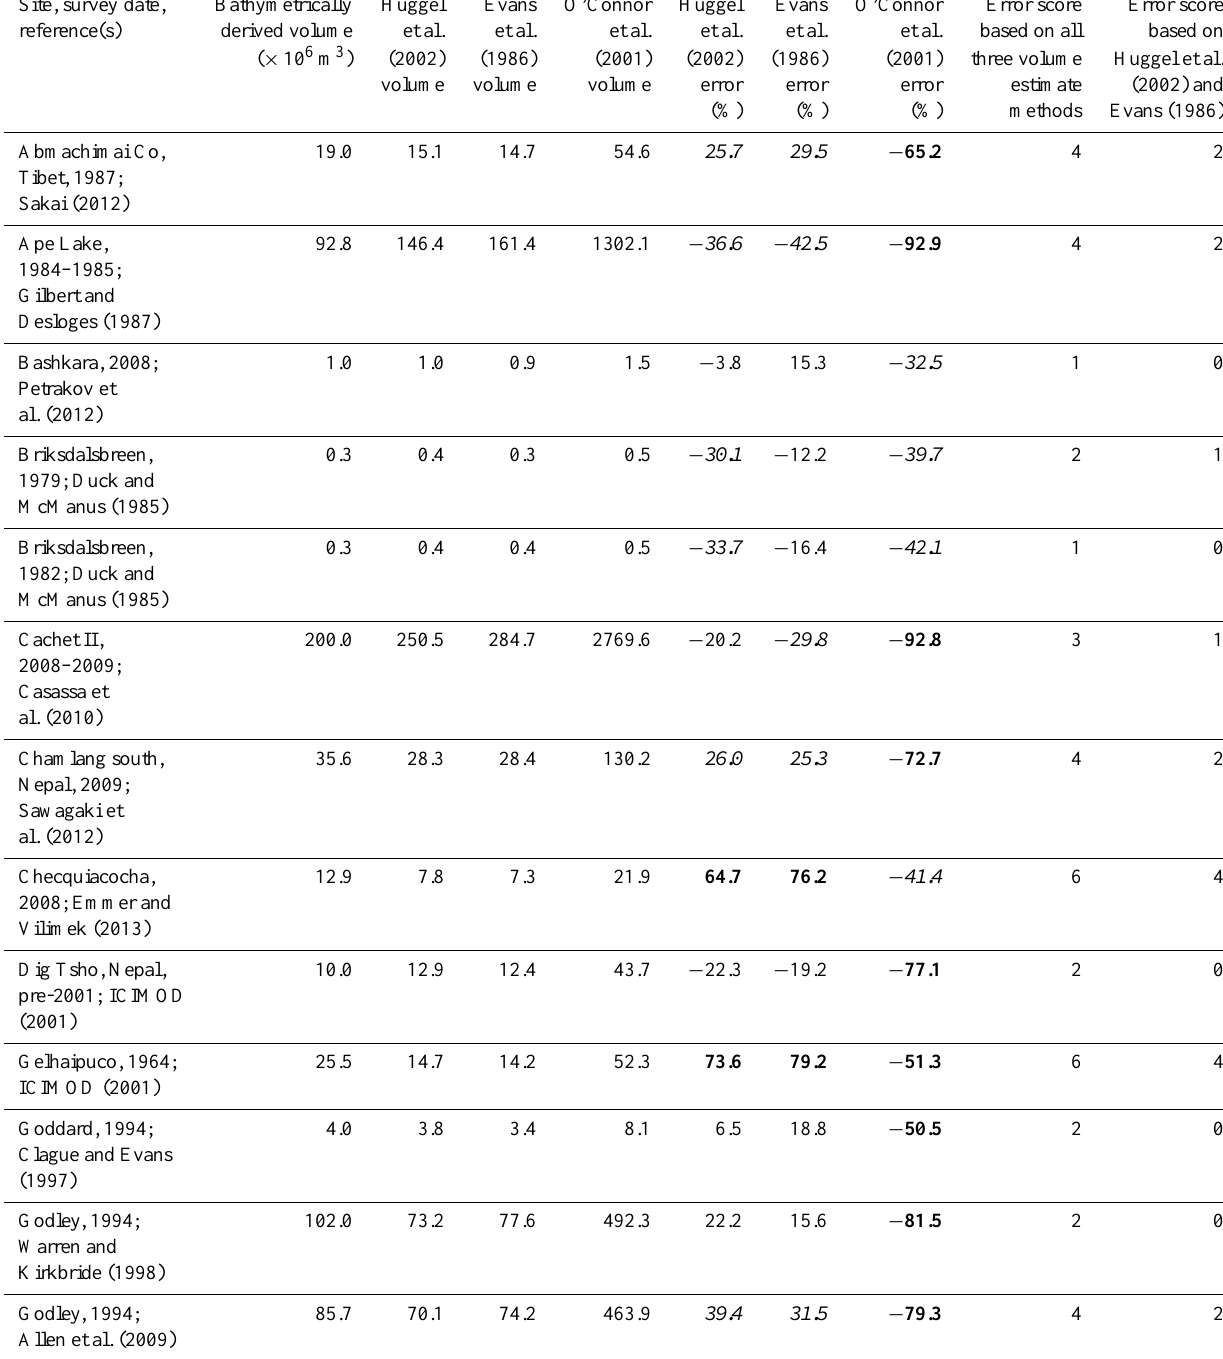
Table 3. Comparison of bathymetrically derived lake volumes with those calculated using existing empirical relationships. Errors are calcu- lated according to Huggel et al. (2004) and coded such that the error between bathymetrically derived and modelled volumes of ± 25–49% is considered “moderately unpredictable” volume (italic), the error ± 50–99% is considered “unpredictable” (bold) and an error of beyond ± 100% is considered “highly unpredictable” (bold-italic). Error scores are provided in the right-hand columns for ease of interpretation. Errors beyond ± 100% are scored 3, errors between ± 50 and 99% are scored 2, errors between ± 25 and 49% are scored 1 and errors of ± 0–24% are scored 0. The first of the right-hand columns is the sum of these scores from all three methods of volume estimation, and the furthest right-hand column is the sum of scores from the models of Huggel et al. (2002) and Evans